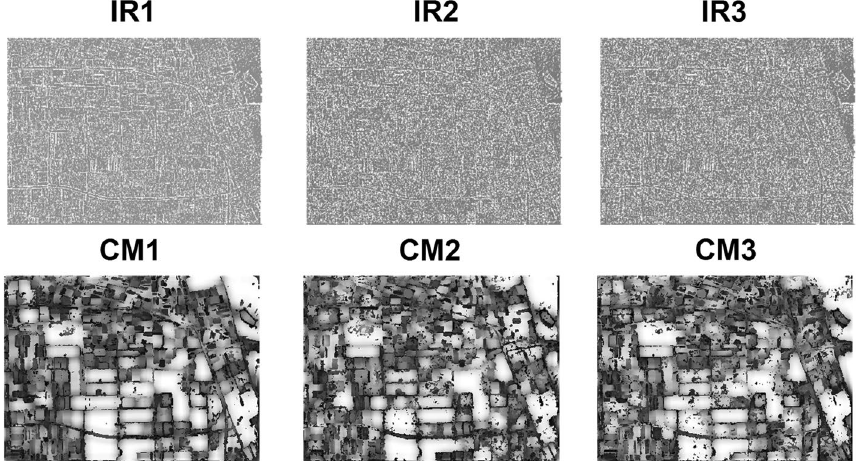
Figure 2. Important regions (IRs) and confidence maps (CMs) for three views of Flevoland